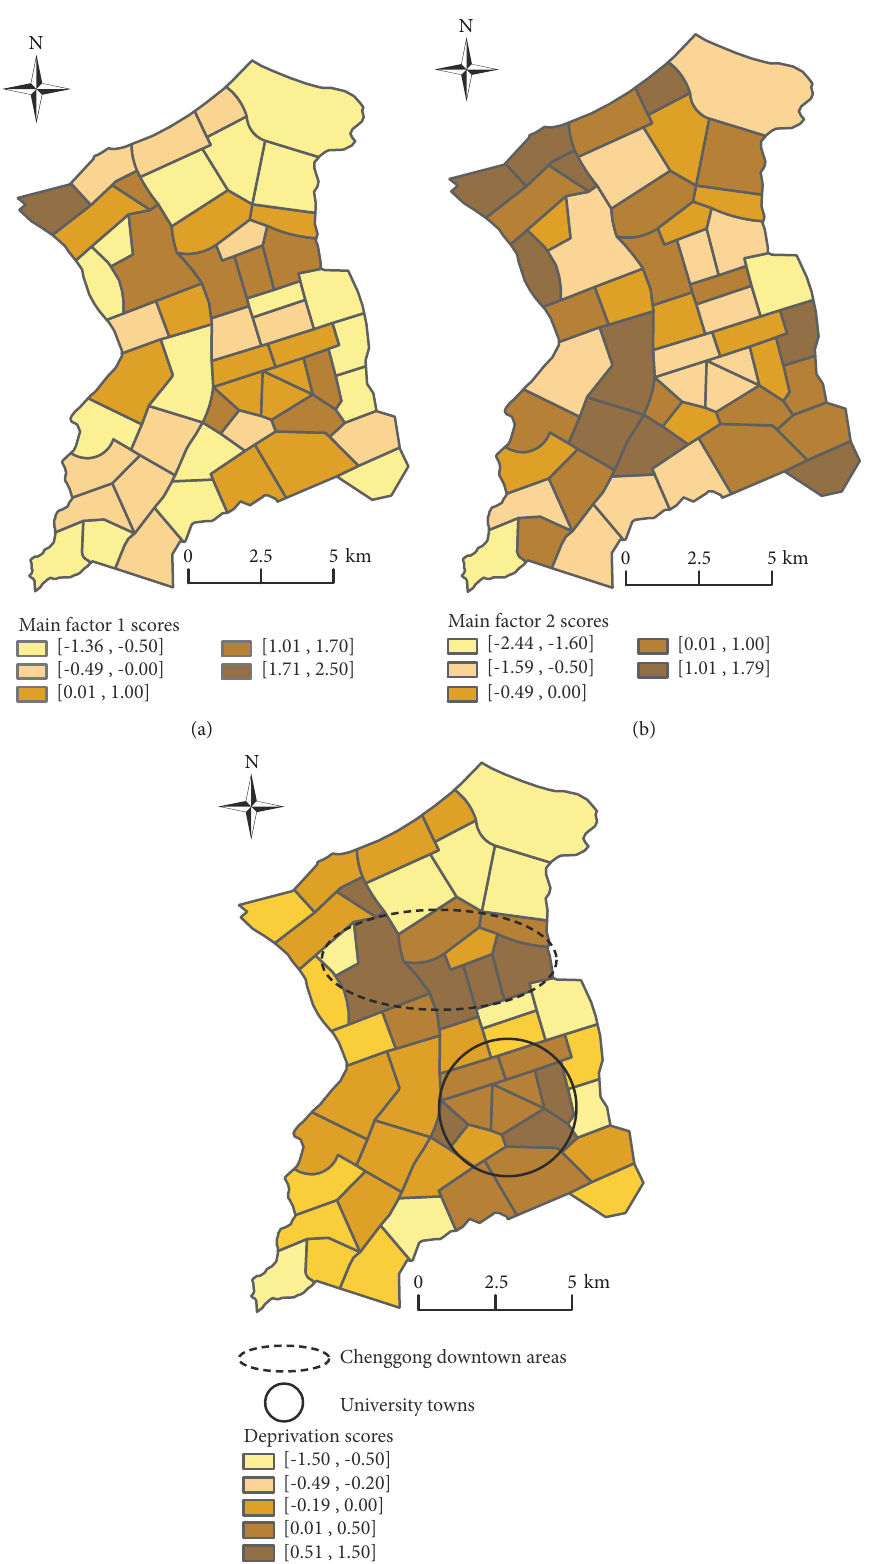
Figure 3: Spatial deprivation distribution of public transportation in Chenggong New